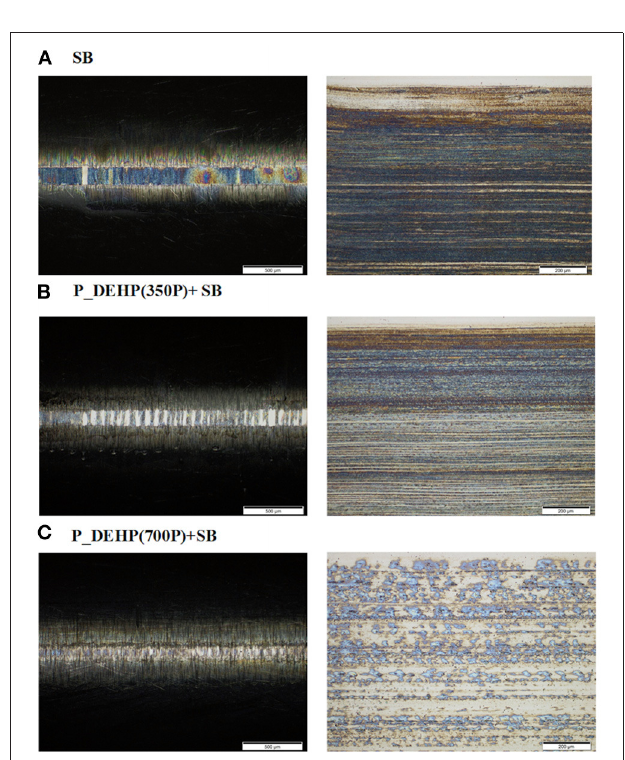
FIGURE 3 | Optical micrographs of wear surfaces on the cylinder (left) and flat (right) test specimens from 1h tribological tests with (A) SB, (B) P_DEHP(350P) + SB, and (C) P_DEHP(700P) + SB oils.